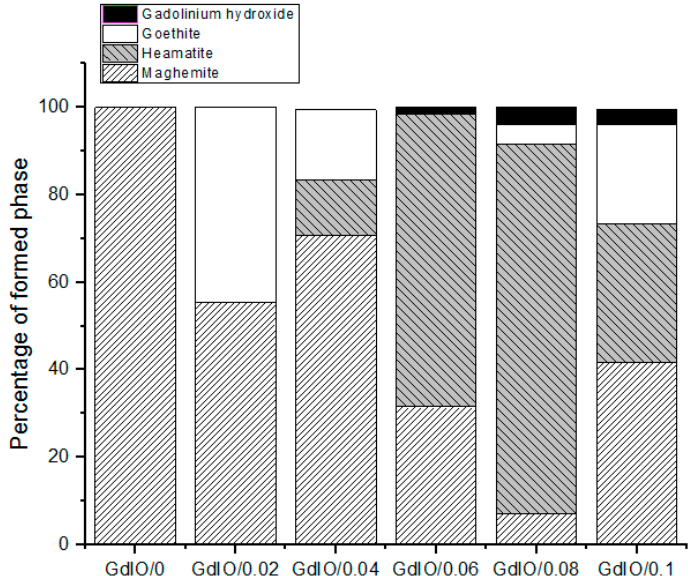
Figure 8. The percentages of the various phases in samples Gd IO/0, Gd IO/0.02, Gd IO/0.04, Gd IO/0.6, Gd IO/0.8 and Gd IO/0.1 from left to right. The patterned bars represent the magnetic phases.